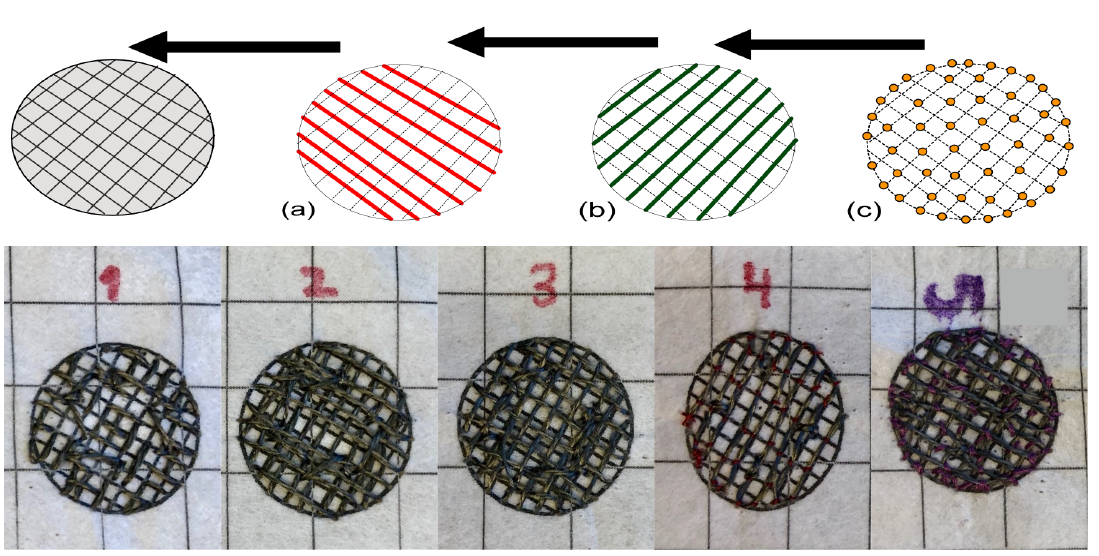
Figure 1. Sewing patterns for electrode fabrication (top row) and typical examples of hand-made electrodes (bottom row). Participants were asked to follow sewing patterns (top row) to learn five techniques for electrode fabrication. To achieve the different techniques, the conductive thread has to be sewn first in ( a ) the red line direction, and then in ( b ) the green lines direction. The yellow dots shown in ( c ) indicate the location of the conductive thread fixations for the couching techniques. Shown are (1) running stitch, (2) float stitch, (3) darning, (4) couching (single line), (5) couching (double line). Detailed sewing instructions are available in Supplementary Document